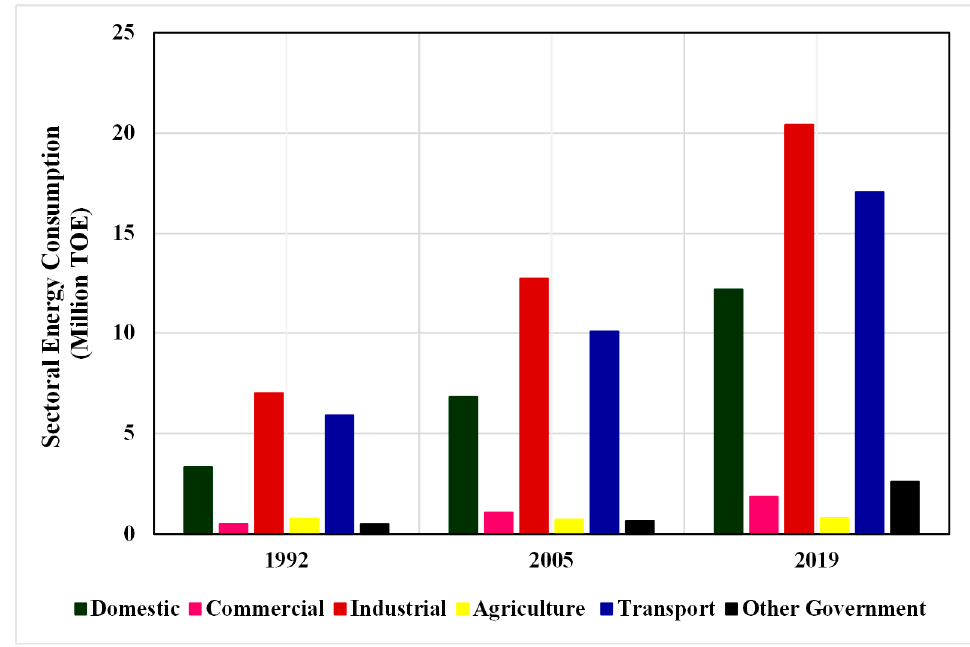
Figure 1 . Energy consumption patterns across various sectors in Pakistan . Figure 1. Energy consumption patterns across various sectors in